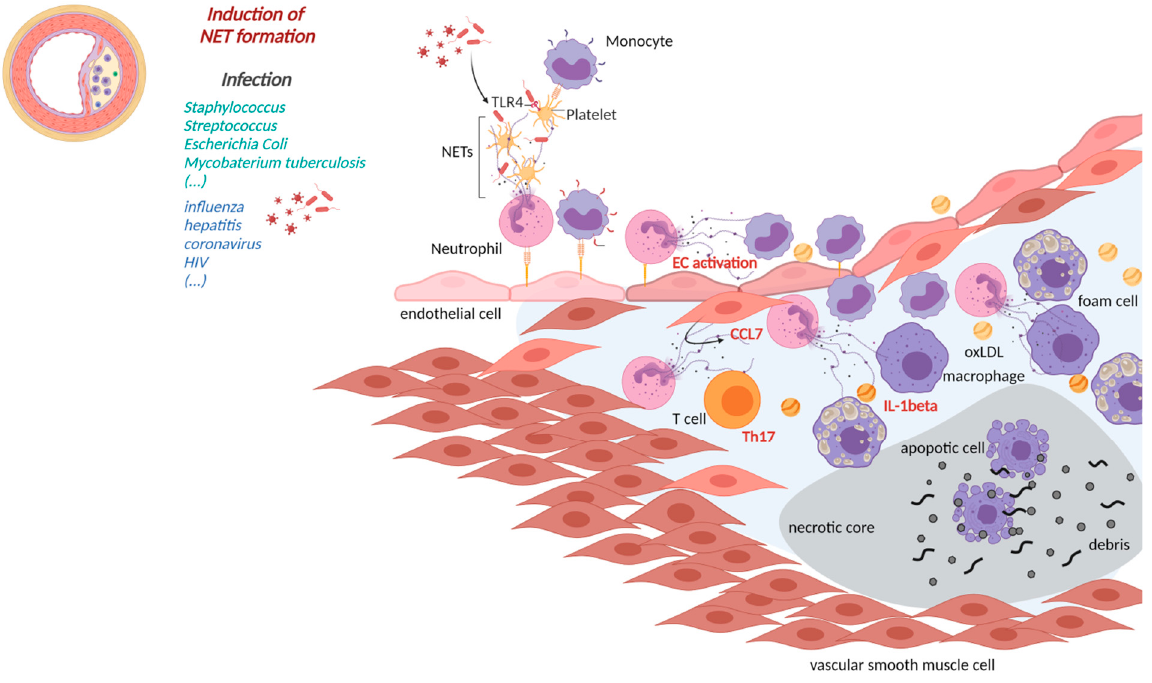
Figure 1. NETs in atherosclerosis. ( Left ): cross section of an atherosclerotic vessel; ( Middle ): pathogens associated with the induction of NETs formation; ( Right ): Close up atherosclerotic lesion; Neutrophils activated e.g., by bacterial and viral pathogens may undergo NETs formation thereby activating leukocytes, platelets and endothelial cells creating a pro-inflammatory milieu triggering lesion growth. Lesional NETs may be induced by pathogens or CCL7 and initiate a IL-1beta release or a Th17 response altogether driving lesion expansion. (made with biorender.com, 4 June 2001).